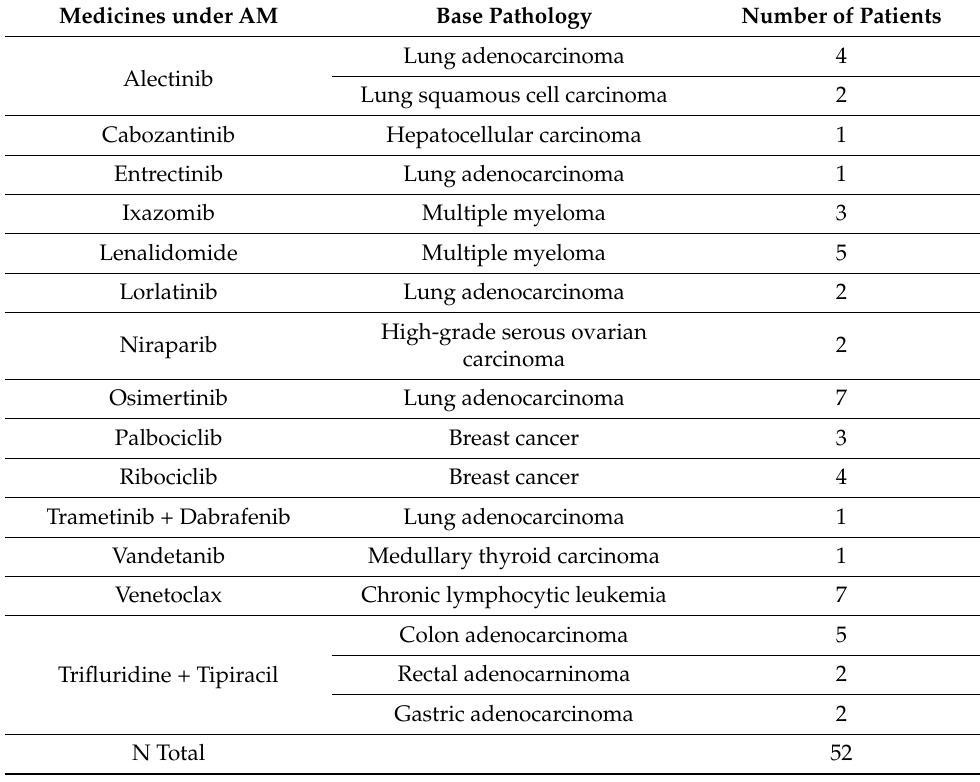
Table 1. Medicines under AM included in the study according to their base pathology.